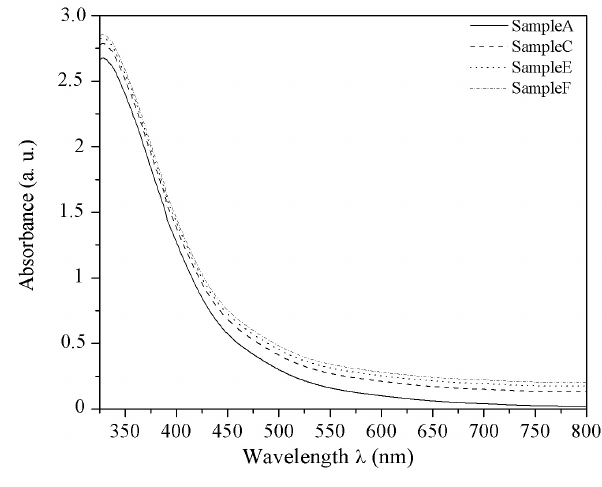
Figure 1. Absorbance profiles for different concentrations of poly(vinyl alcohol) (PVA) + FeCl (samples A, C, E, and F). 3